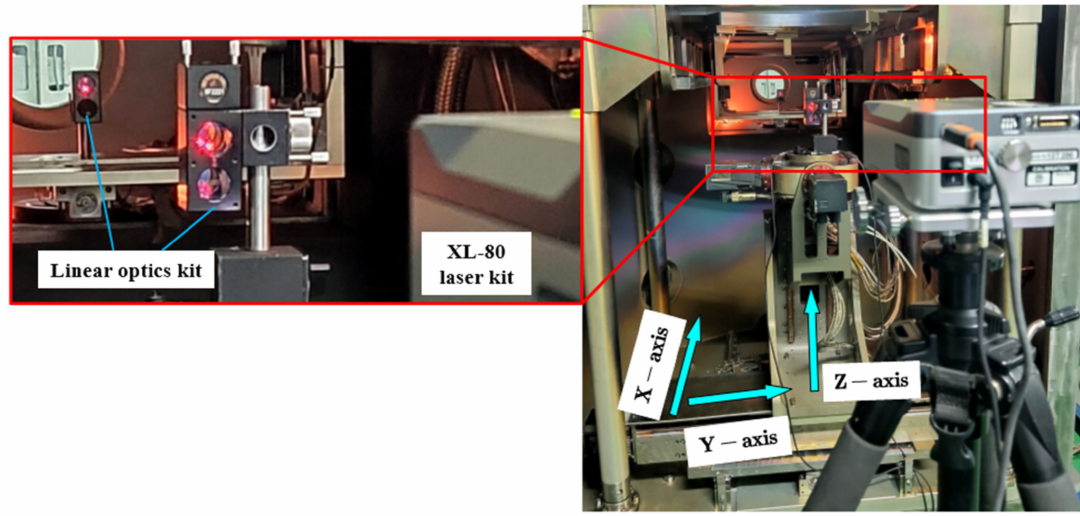
Figure 15. The measurement setup for measuring the positioning error of